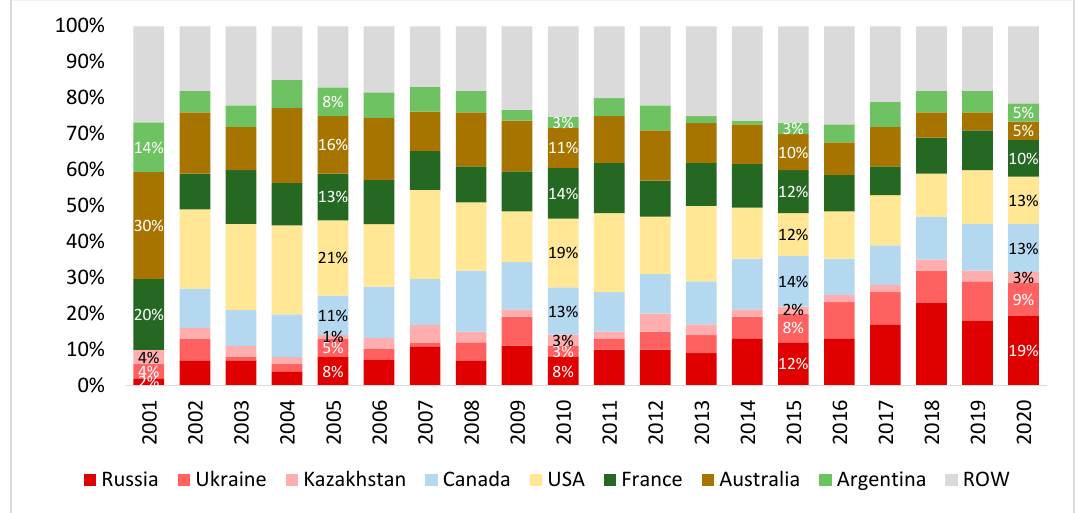
Figure 3. Shares of selected leading wheat exporting countries (2001–2020). Data source: [24]. Own illustration.